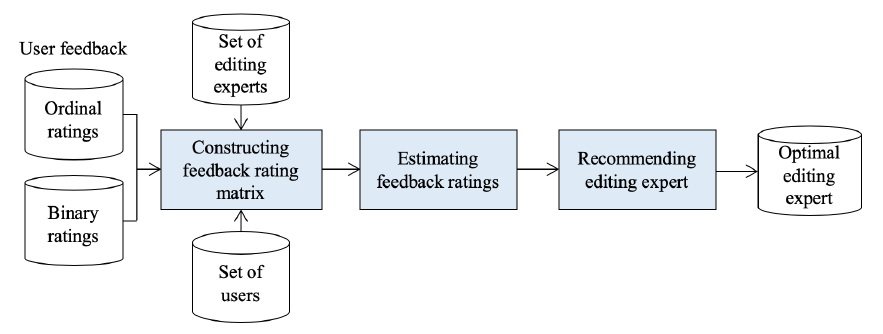
Figure 4. Overview of the proposed non-negative matrix factorization based editing expert recommender